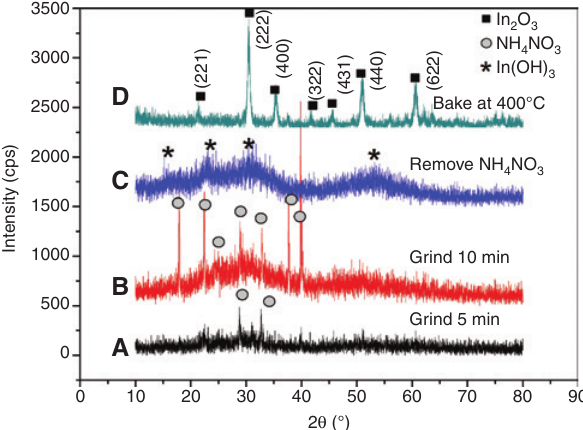
Figure 2: XRD patterns of the (A) mixture after grinding 5 min, (B) mixture after grinding 10 min, (C) In(OH) (D) mixture baked at 400 °